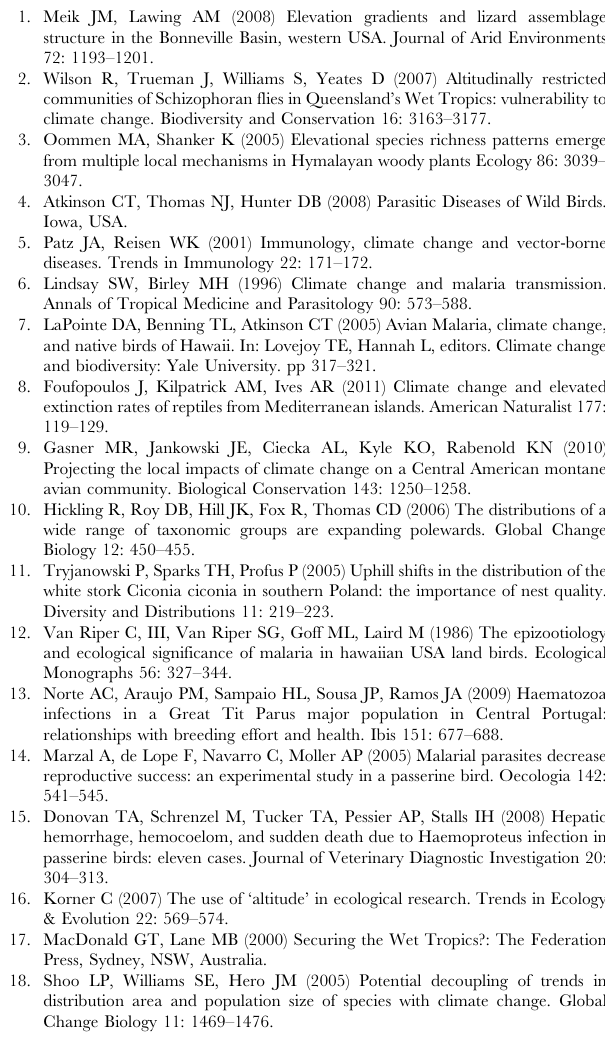
Table S4 Regressions between Parasite prevalence and host ecological variables. Relationships between Parasite prevalence and host: a) Geographic range size, b) Body mass and c) Body size. All regressions are low and none